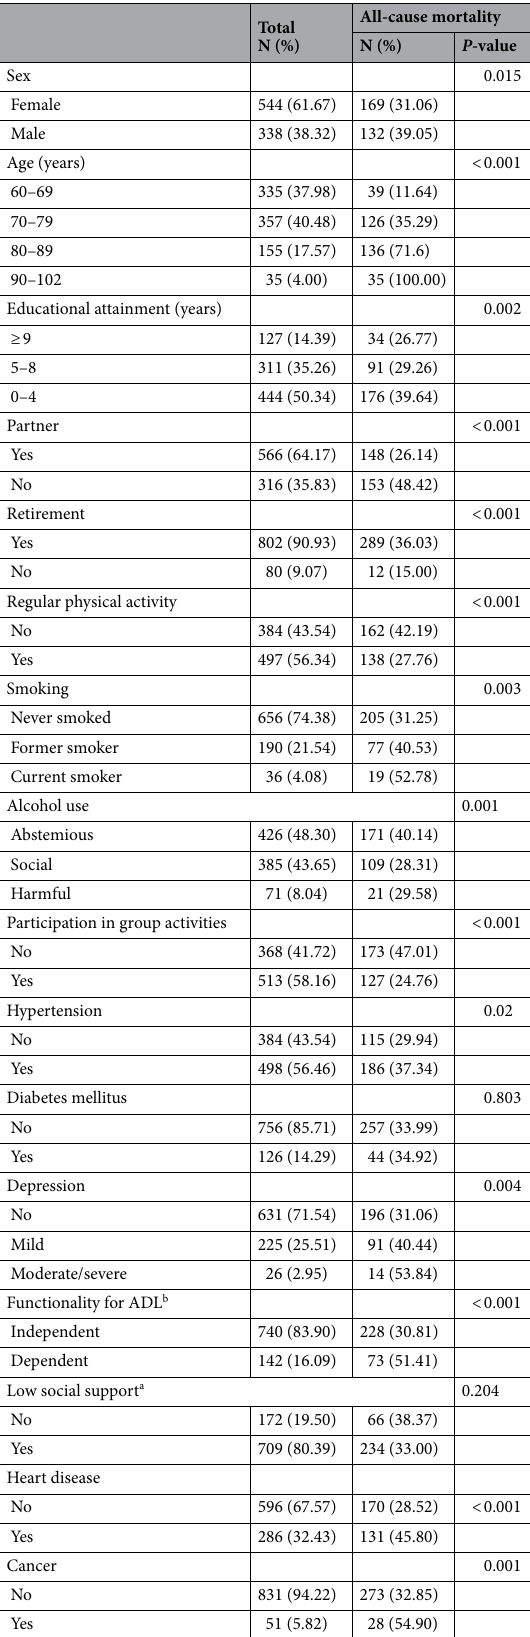
Table 1. Characteristics associated with mortality in older adults (n = 882). a Low social support: < 80th percentile on MOS score. b Functional independence: Barthel Index =